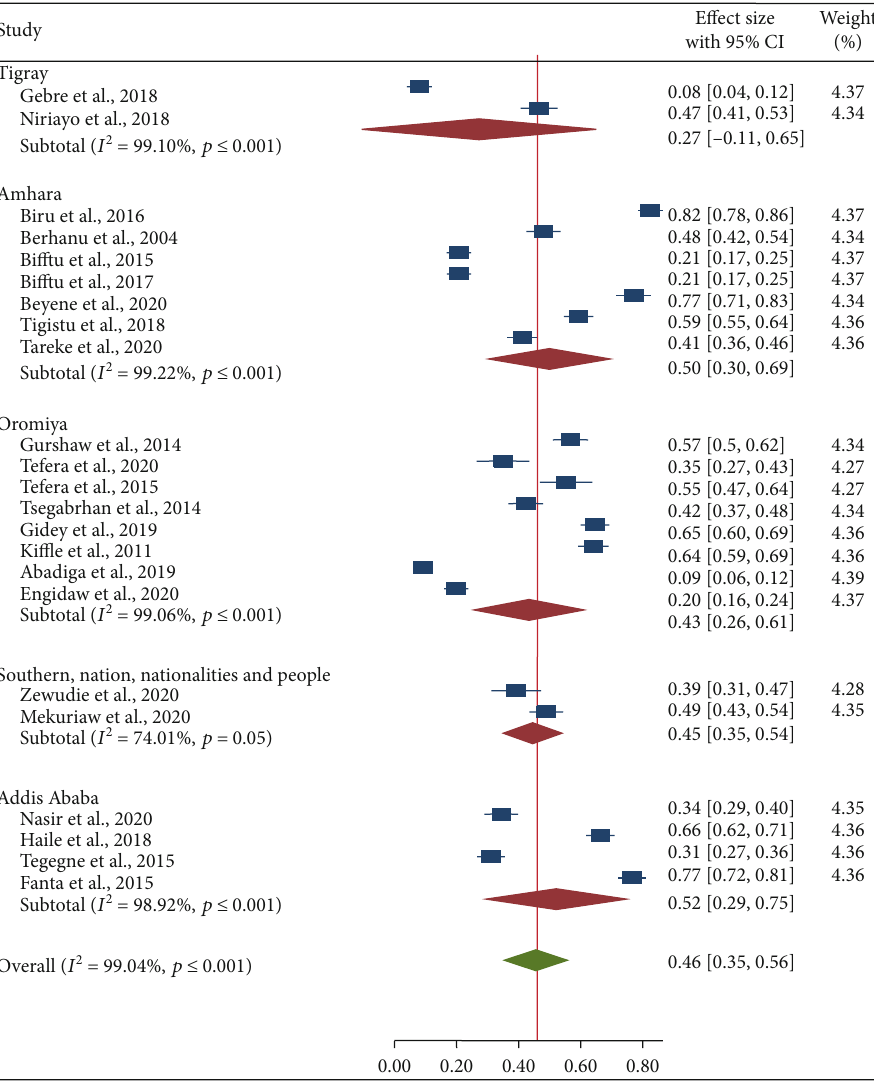
Figure 3: Forest plot depicting subgroup analysis of the pooled prevalence of seizure freedom by study